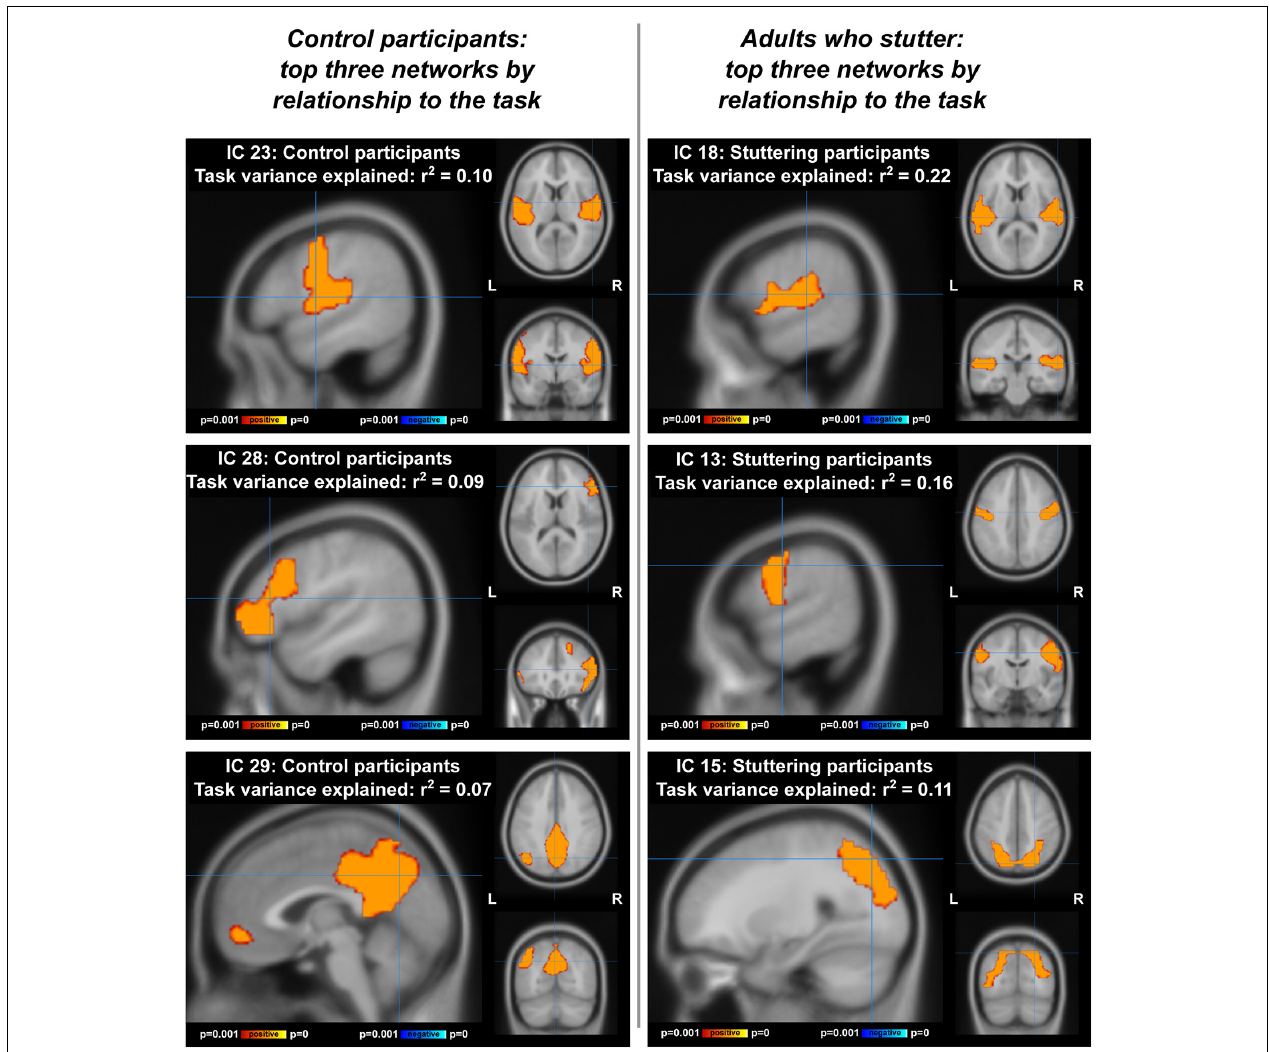
FIGURE 6 | Top three networks, by relationship to the compensation task, for ICA performed separately on each group. IC, independent component. Left: adult controls (AC), at coordinates [54 − 4 10] for IC 23, [48 30 12] for IC 28, and [0 28 42)] for IC 29. Right: adults with a stutter, at coordinates [58 − 24 12] for IC 18, [60 − 8 38] for IC 13, and [26 − 74 48] for IC